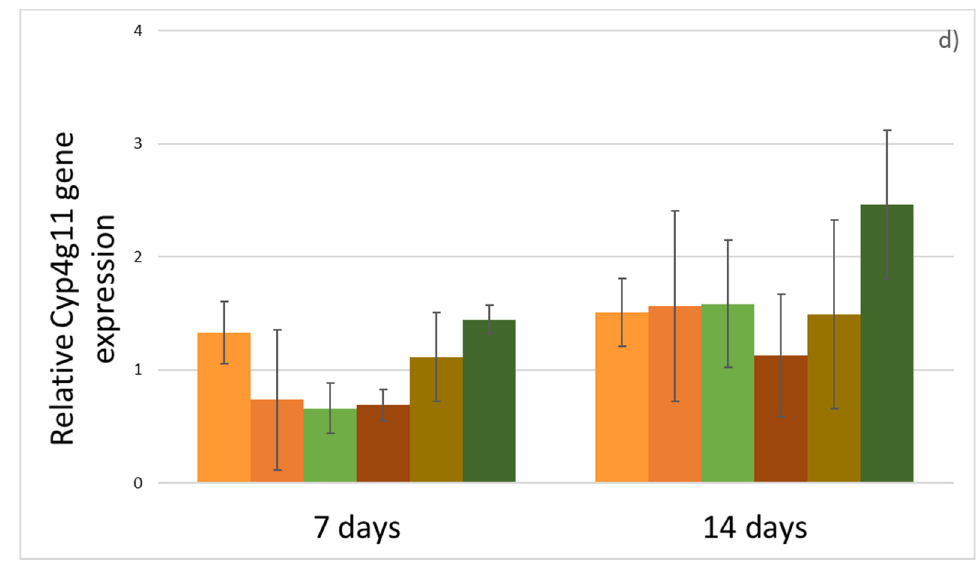
Figure 3. Relative expressions of four cytochrome P450 genes in bee workers depending on treatment at the 7th and 14th days of the experiment. Error bars denote two technical replications of three samples. ( a ) CYP9Q1 gene, ( b )CYP9Q2 gene, ( c ) CYP9Q3 gene, ( d ) CYP4G11 genes.